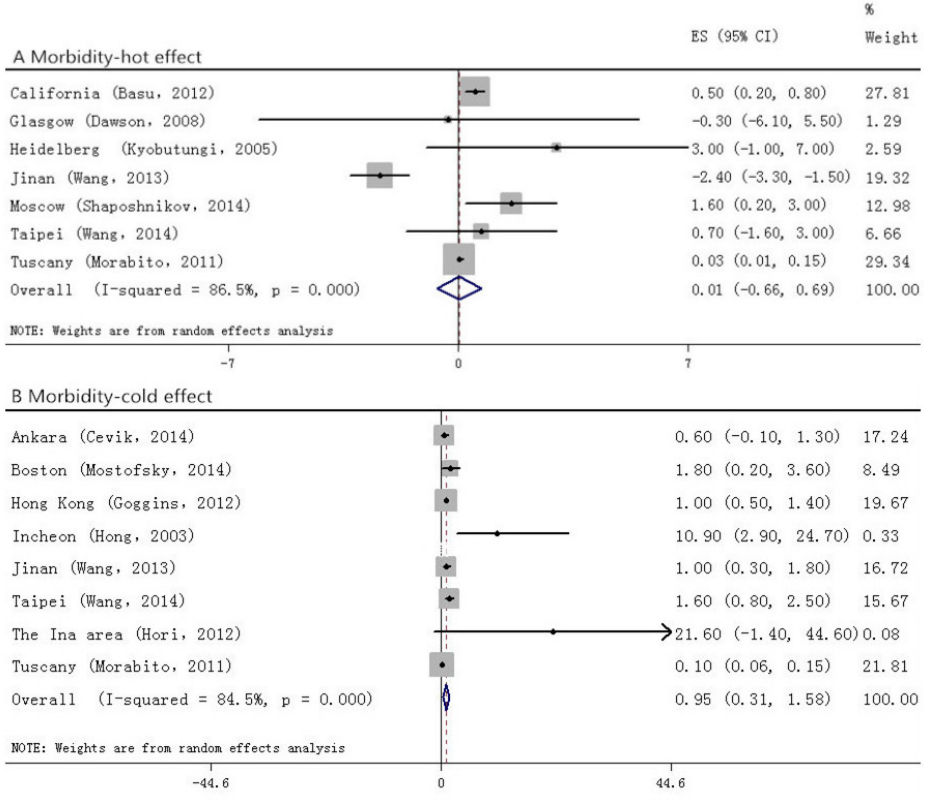
Figure 3. Forrest plots for relationship between the temperature change and stroke morbidity. A and B stand for hot and cold effect,